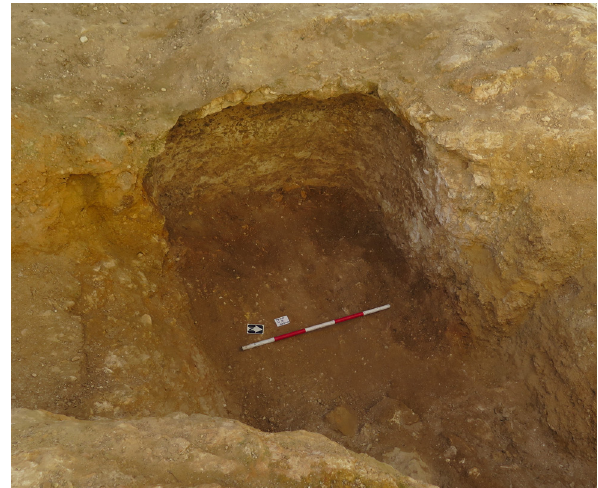
Figure 13: General view of the truncated chamber with the unexcavated deposits.